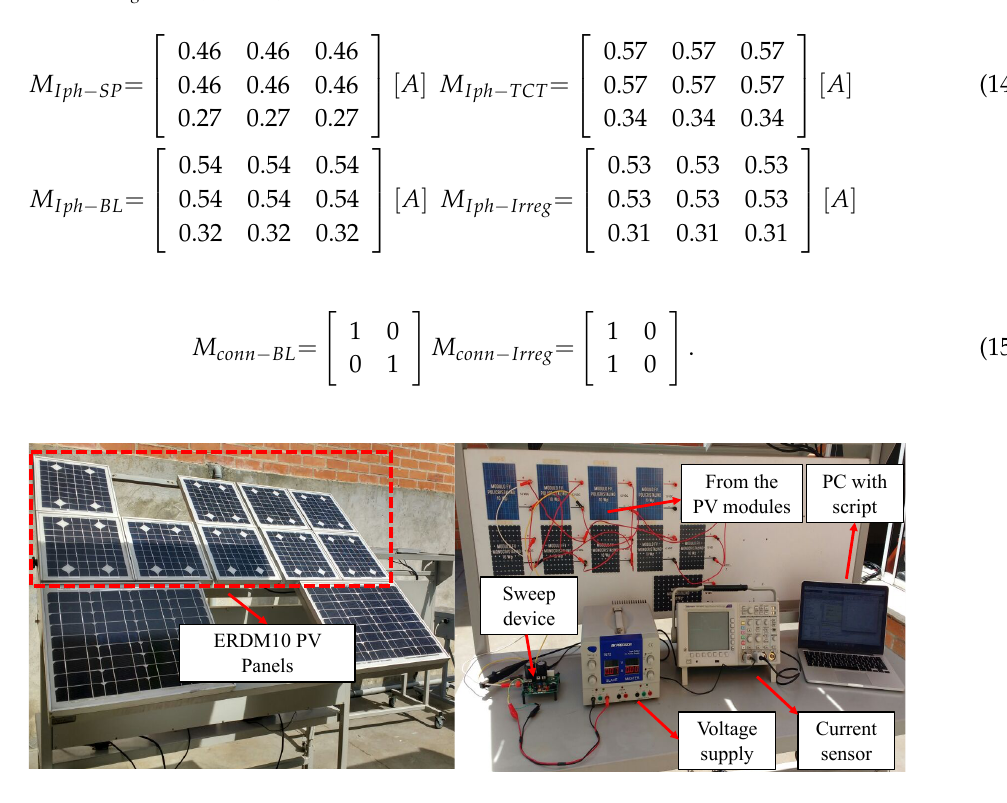
Figure 6. Experimental platform. Table 1. Parameters for experimental